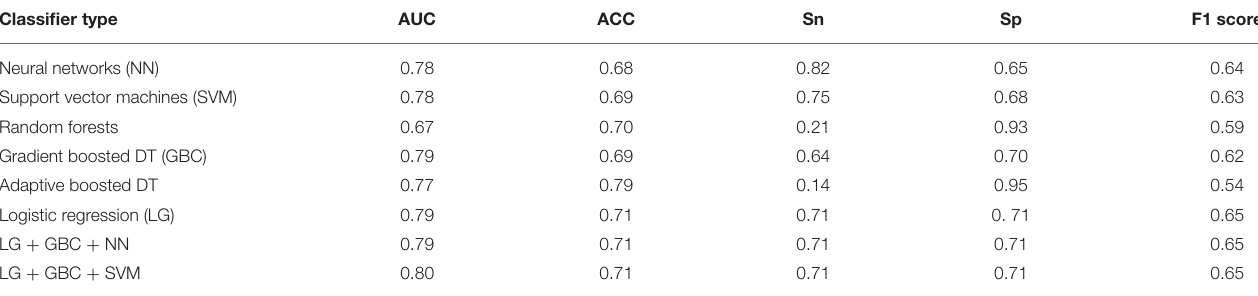
TABLE 2 | Performance evaluation of the different machine learning models using the model-selection dataset (143 patients; 28 positive heart failure